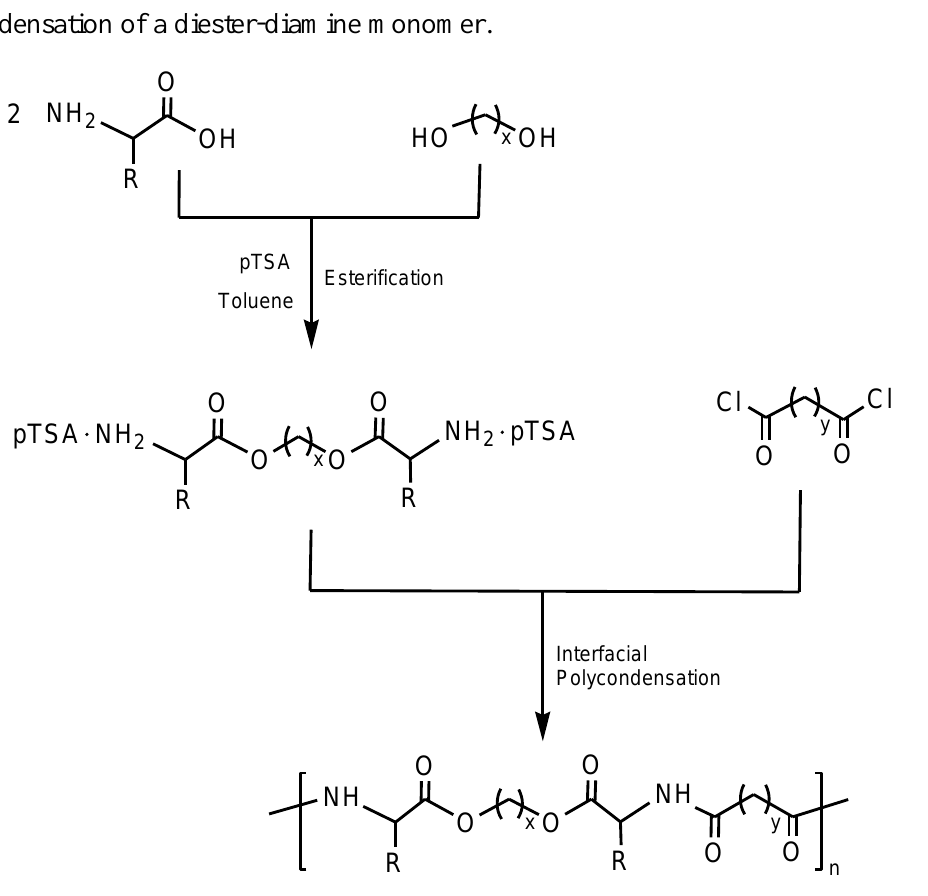
Figure 5. Main activating groups ( a ) and condensing agents ( b ) employed in solution polycondensation